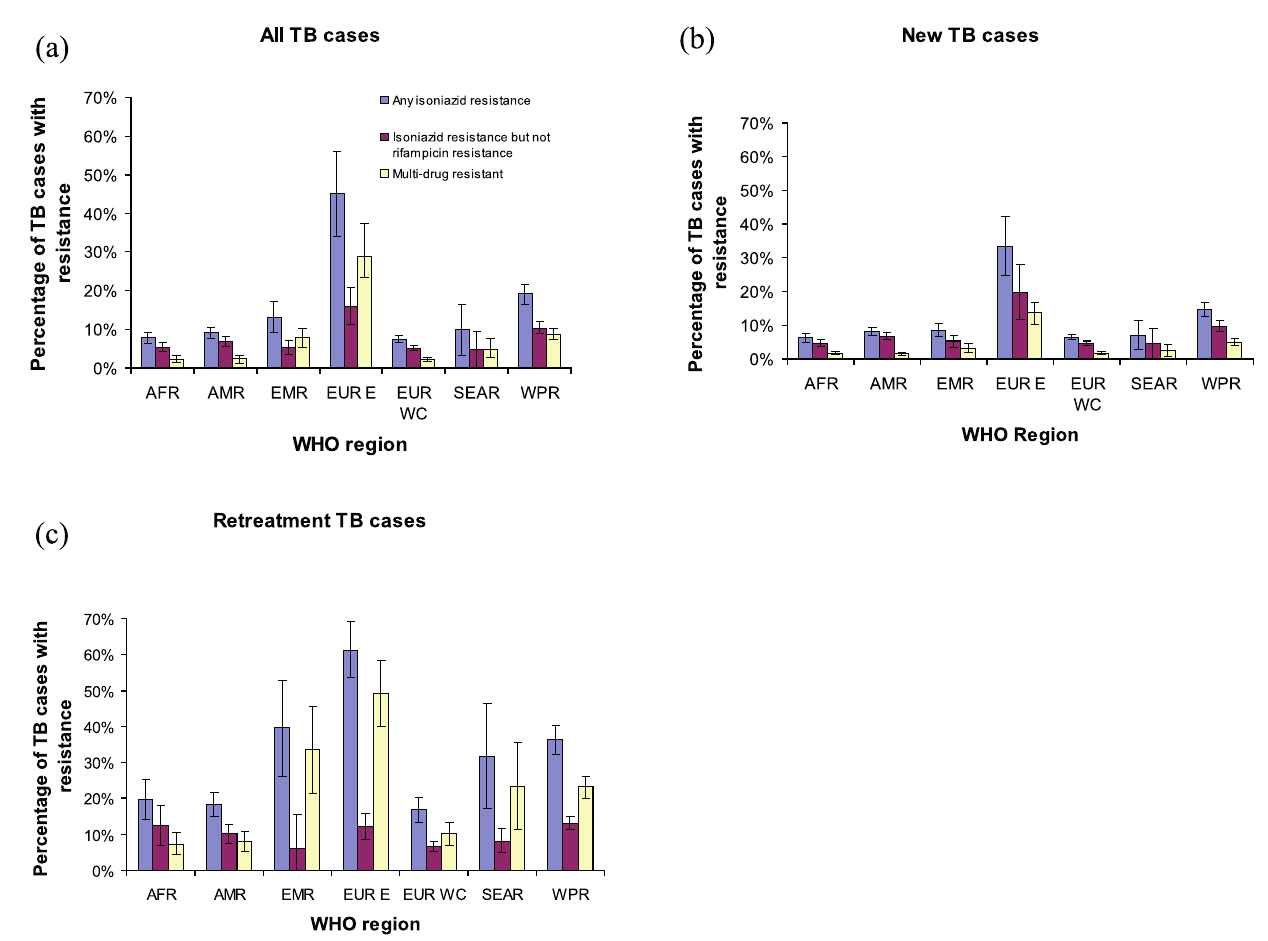
Figure 2. Percentage of all, new and retreatment TB cases with isoniazid resistance by WHO region. Percentage of (a) all TB cases, (b) new TB cases and (c) retreatment TB cases with any resistance to isoniazid, resistance to isoniazid but not rifampin and multi-drug resistance by WHO region (AFR= African region, AMR= region for the Americas, EMR= Eastern Mediterranean region, EUR E= Eastern European region, EUR WC= Western and Central European regions, SEAR= South-East Asian region, WPR= Western Pacific region). Countrywide data only from the most recent survey available 1994-2009. Blue bars represent any isoniazid resistance, red bars represent isoniazid resistance without rifampin resistance and white bars represent multi-drug resistance.